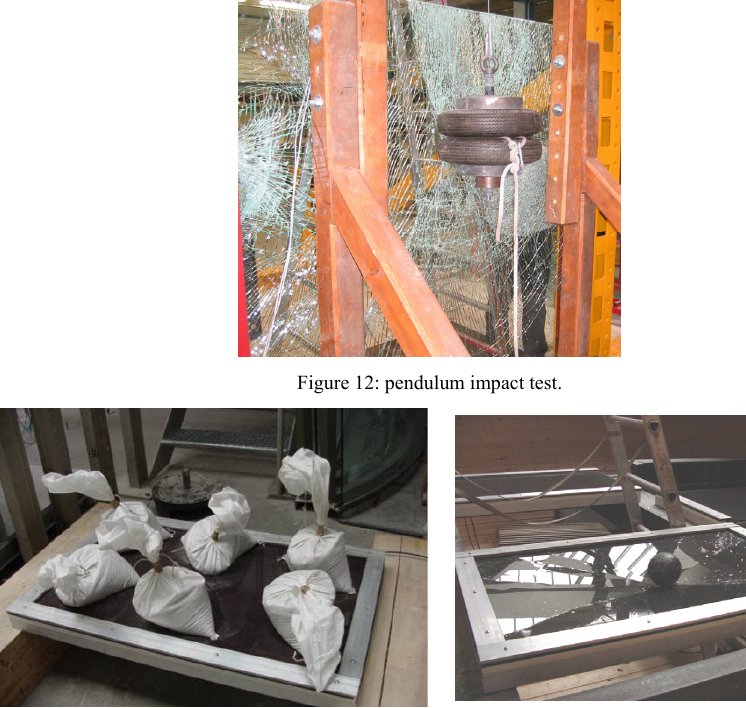
Figure 13: Remaining load carrying capacity test [15], Figure 14: Impact test at T= 70°C